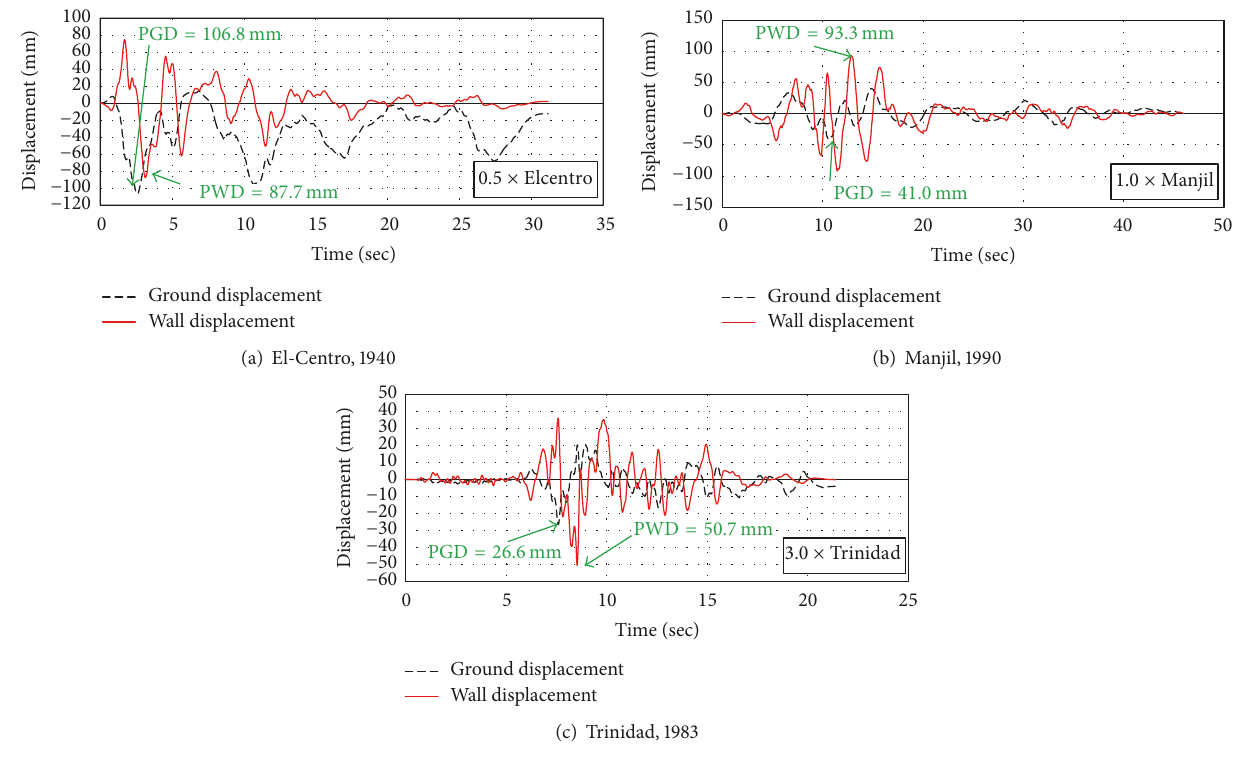
Figure 14: Sample seismic response of the considered infill walls subjected to different ground motions.